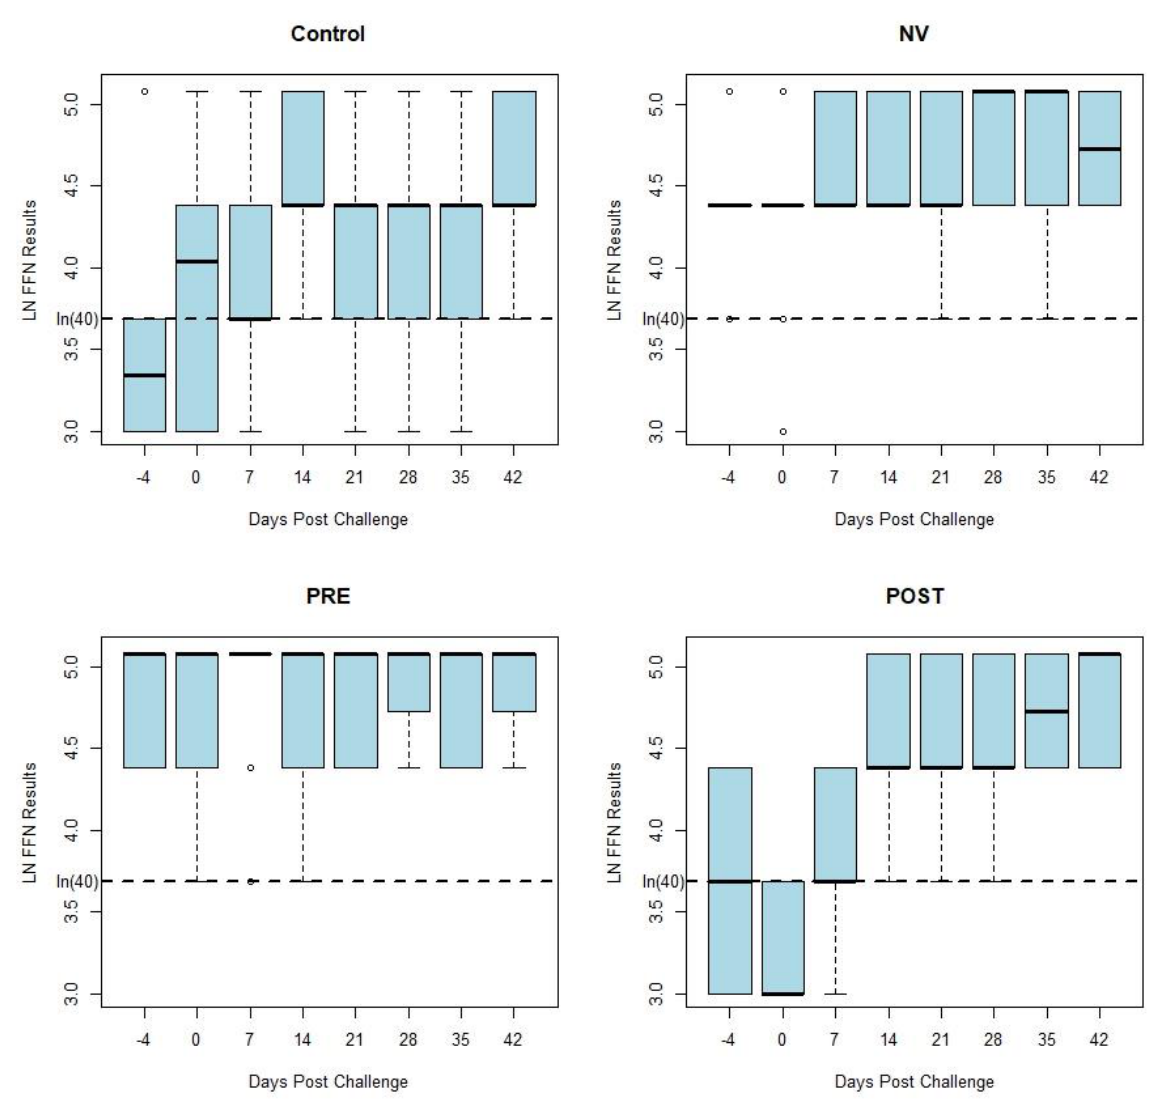
Figure 2. Box-and-whisker plots of the FFN antibody response curves by the days post challenge for each treatment group. The middle bar represents the median value of the results by week. The hinges (top and bottom of the box) represent the first (Q1) and third (Q3) quartiles. The shaded region represents the interquartile range (IQR). The whiskers are determined as follows: Top whisker = Q3 + 1.5 * IQR; Bottom whisker = Q1 + 1.5 * IQR. If no data point is at the calculated value, the next data point closest to Q1 or Q3 is the limit of the whisker. Open circles ( ◦ ) indicate outliers. A cut of 40 is denoted by the dashed line at ln(40) on the y-axis.